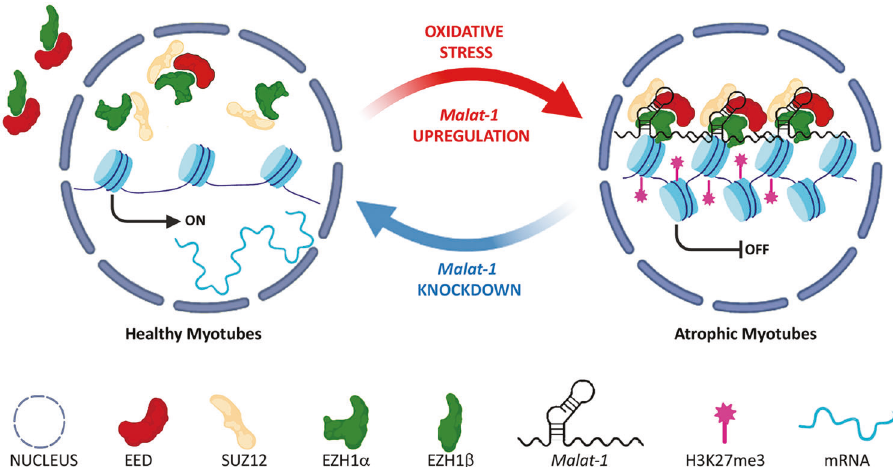
Fig. 5 Graphical summary. Upon oxidative stress, the cytosolic fraction of EED moves into the nucleus where the upregulated Malat-1 stabilizes the PRC2-EZH1 complex on skeletal muscle genes, mediating their silencing and the onset of the atrophic phenotype. Malat-1 depletion produces a loss of H3K27me3 on myogenic genes and reverts the atrophic